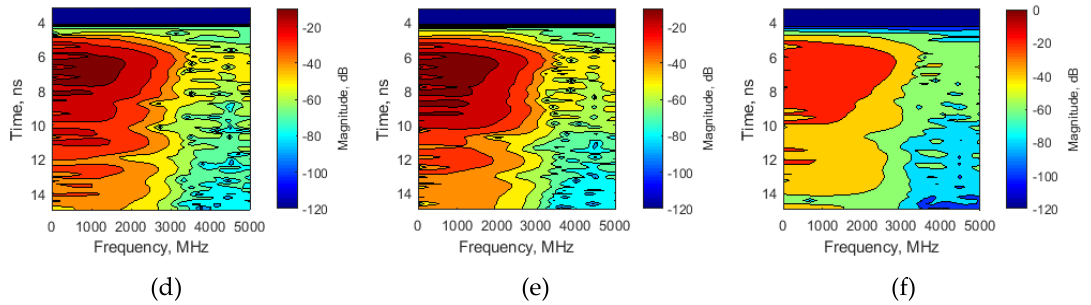
Figure 12. STFT spectra collected with the 1000 MHz antenna at the centre of the ballast slots (i.e., sleepers are excluded) with FI = 0% ( a , d ), FI = 15% ( b , e ) and FI = 25% ( c , f ), for dry ( a – c ) and wet ( d – f ) samples.